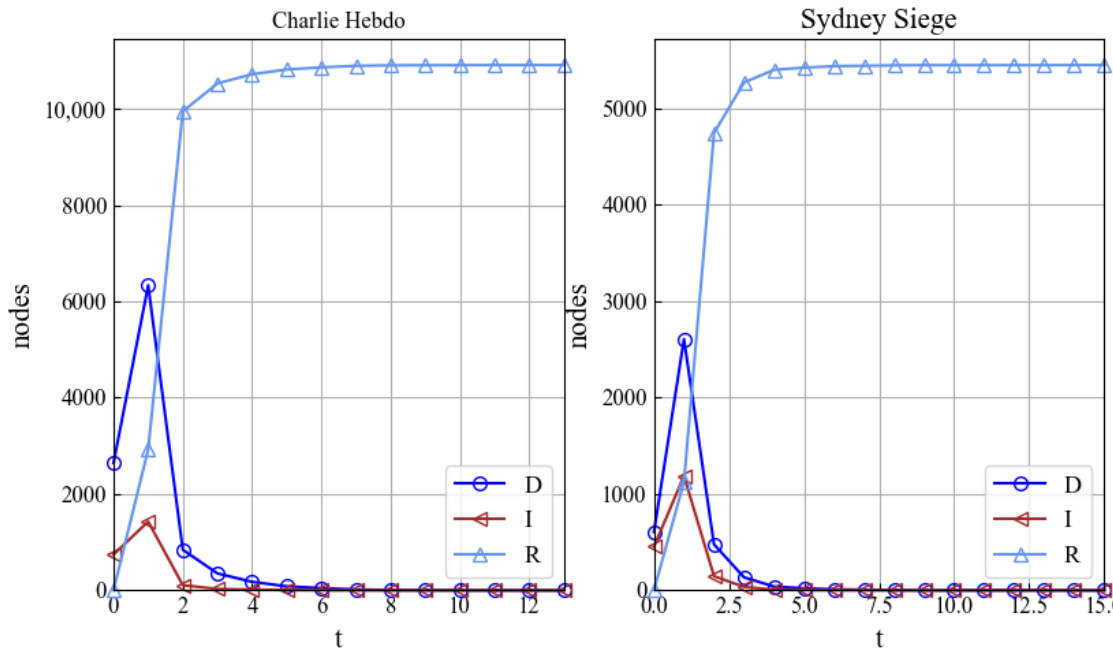
Figure 4. Competing dissemination trends of SDIR